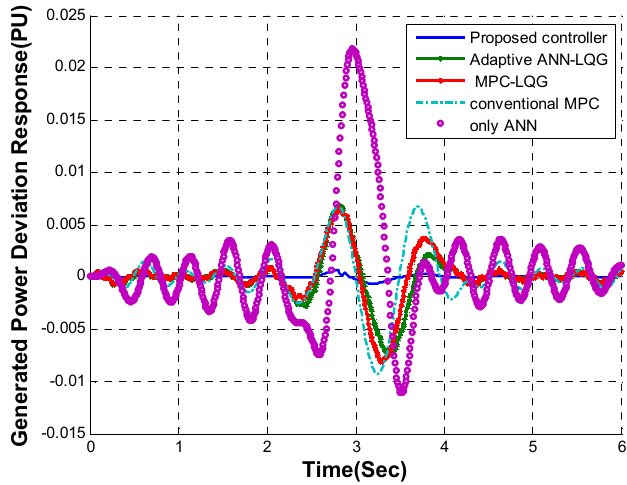
Figure 11. Generated power deviation response.